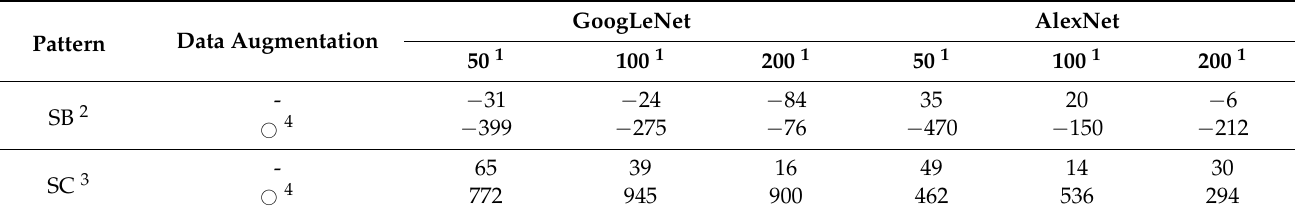
Table 3. Comparison between simultaneous identification of broadleaf and coniferous trees and individual identification of broadleaf and coniferous